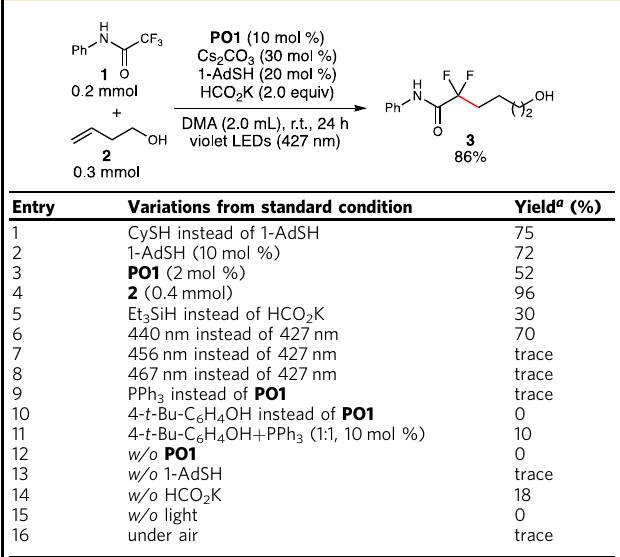
Table 1 Key reaction-controlling parameters.